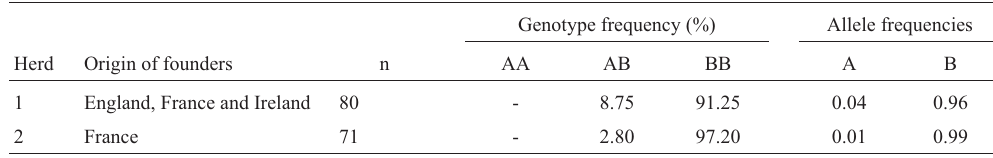
Table 1 - Allelic and genotypic frequencies of the myostatin Q204X allele.